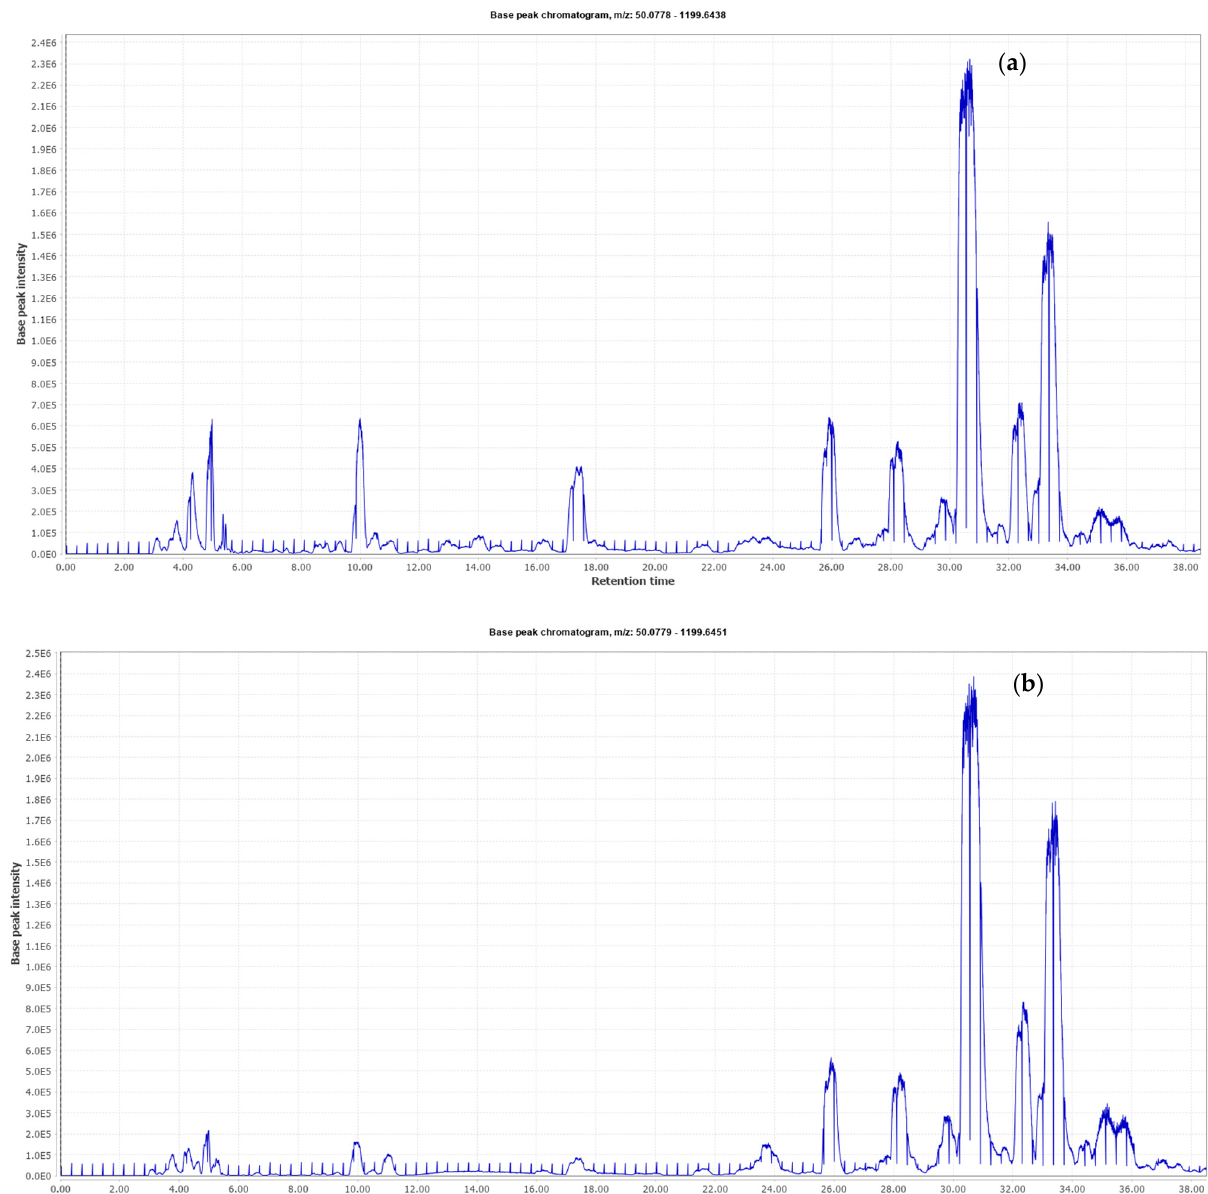
Figure 1. Base peak chromatograms of O20 ( a ) and O30 ( b ) olive byproduct extracts obtained by high performance liquid chromatography coupled to mass